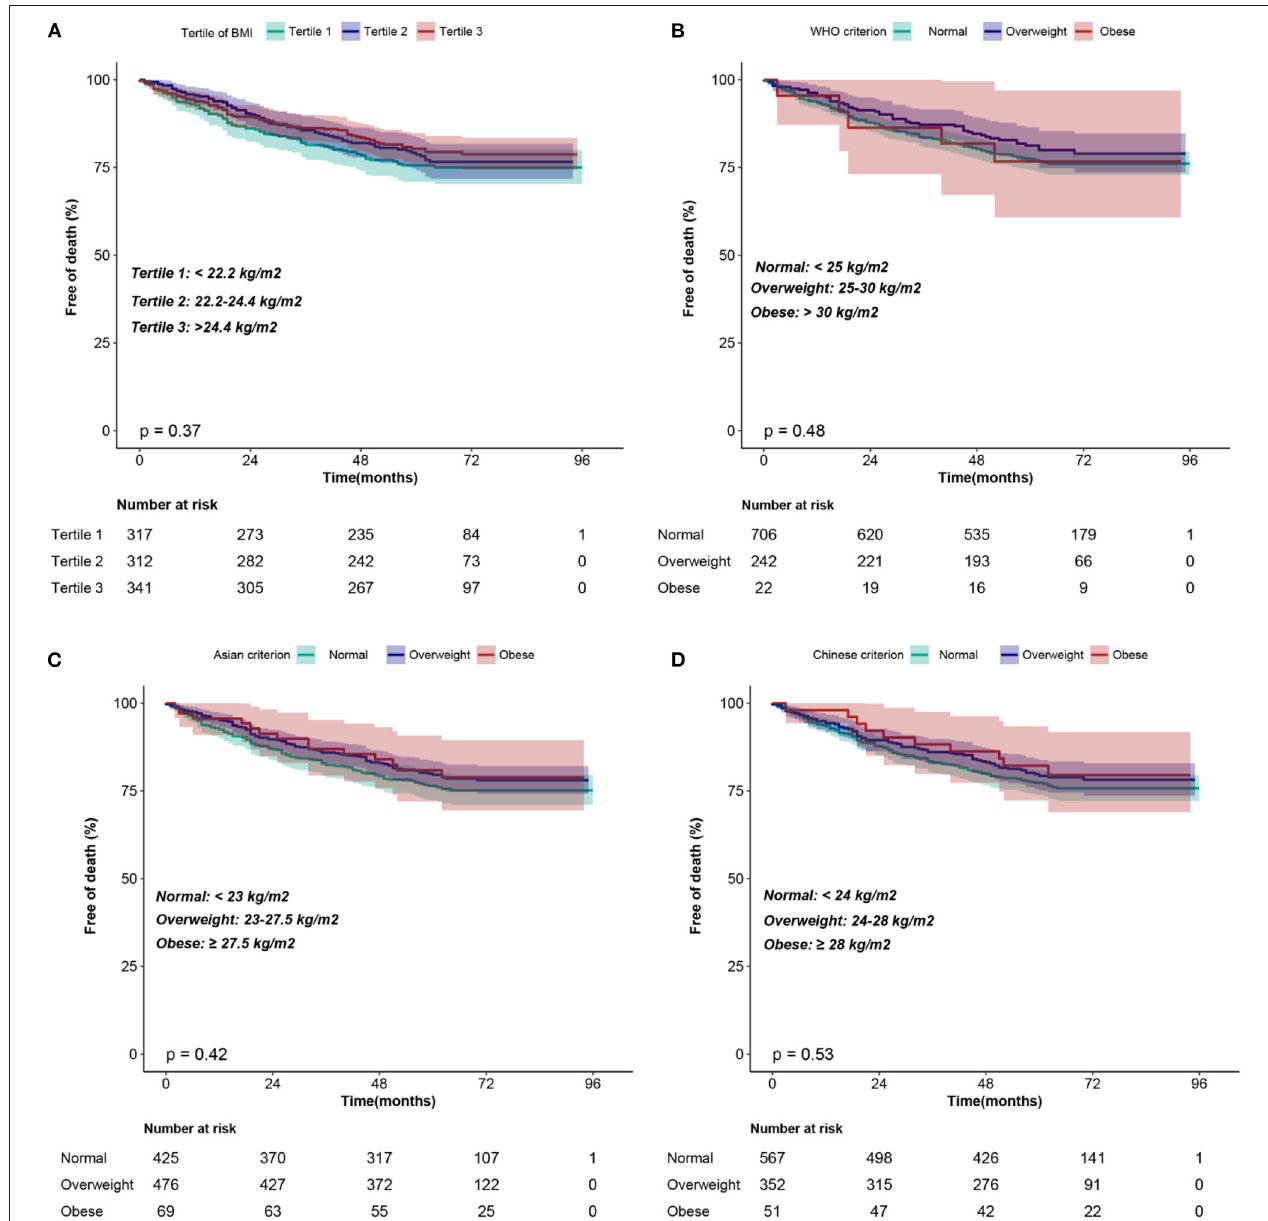
FIGURE 2 | Kaplan–Meier curves of the cumulative probability of survival according to the BMI classification of (A) tertiles, (B) WHO criterion, (C) Asian criterion, (D) Chinese criterion. BMI, body mass index.